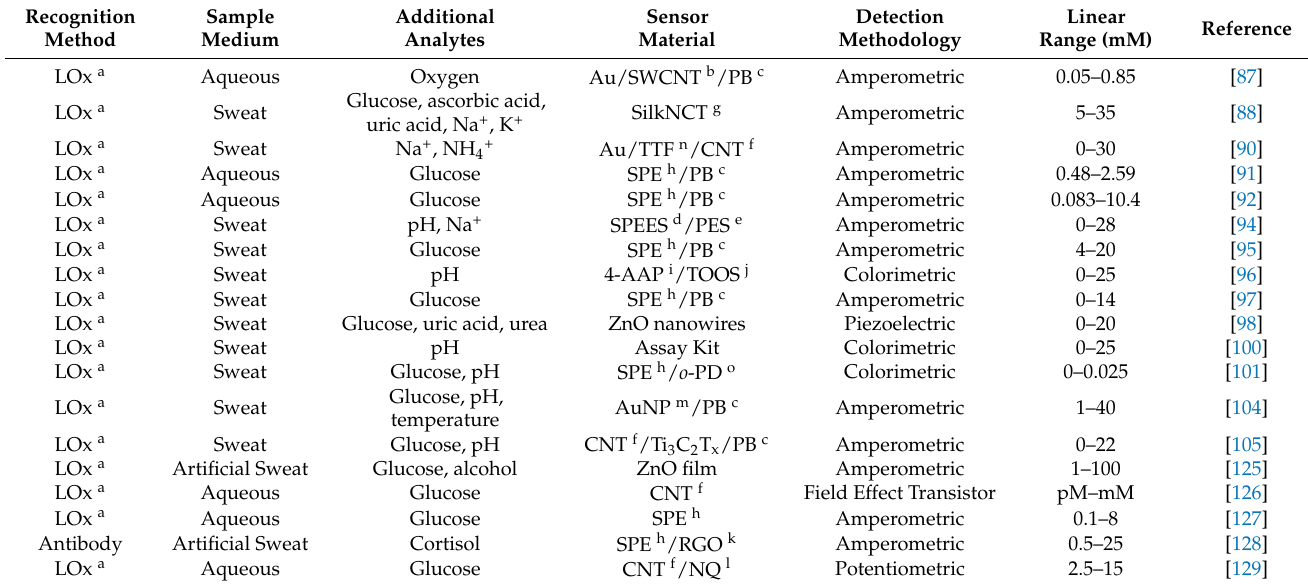
Table 4. Summary of multi-analyte sensor platforms for the detection of lactate, highlighting the materials used, method of detection, biological medium, linear range, and limit of